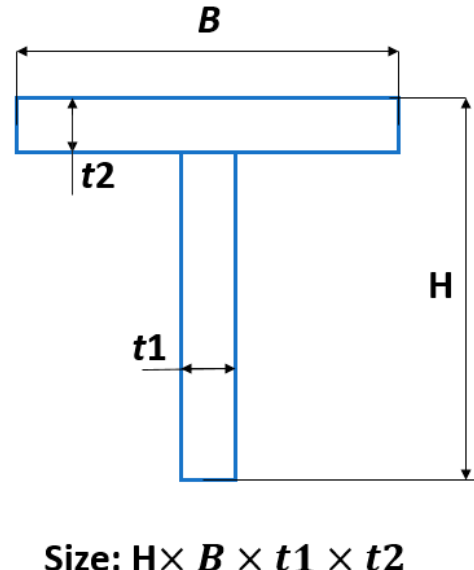
Figure 1. Specifications of the cross-section of the T-shaped beam. B : flange width, H: height of section, t 1: web width, t 2: slab thickness. Table 1. Specifications of T-shaped reinforcements for di ff erent materials of the compartment.